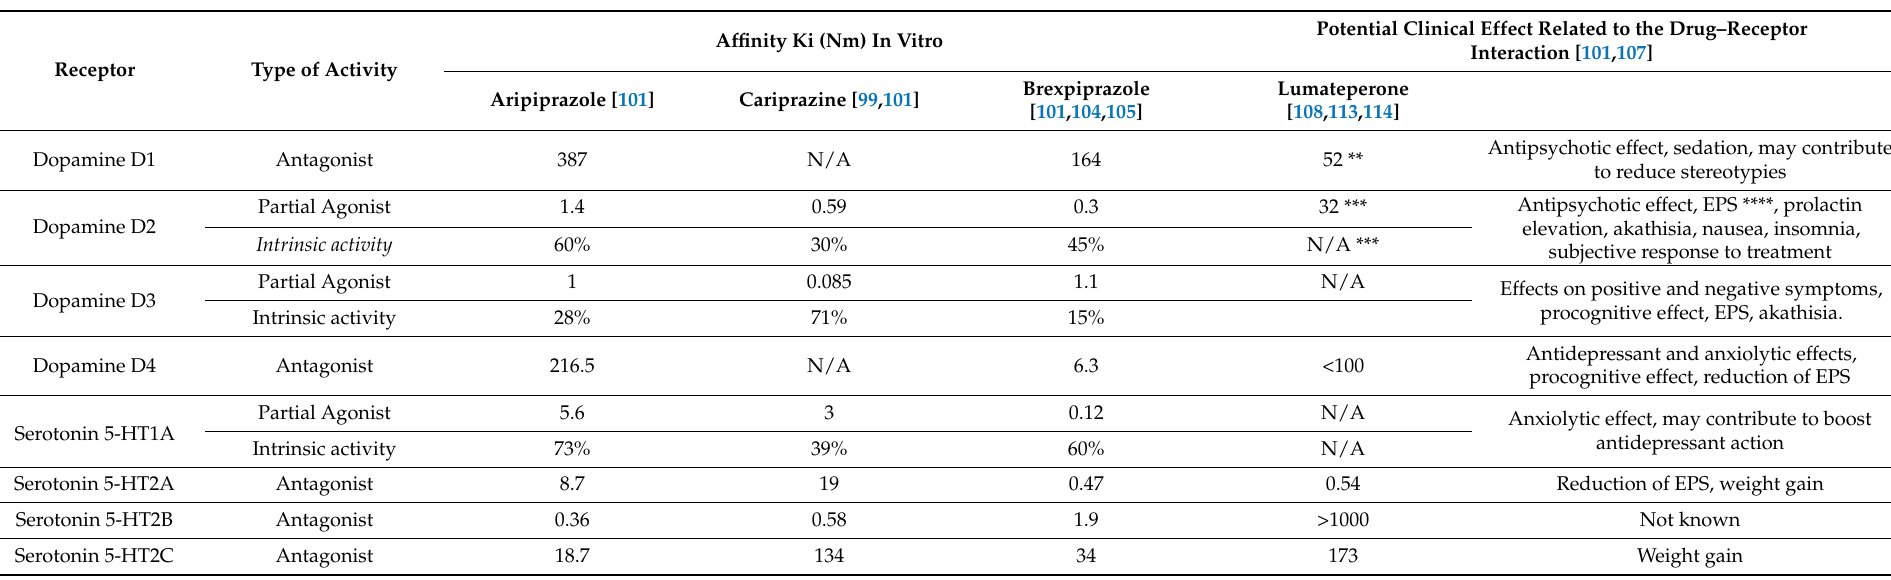
Table 1. Human receptor affinity of serotonin and dopamine activity modulators (SDAMs) approved * for the treatment of schizophrenia and potential clinical effect related to the drug–receptor